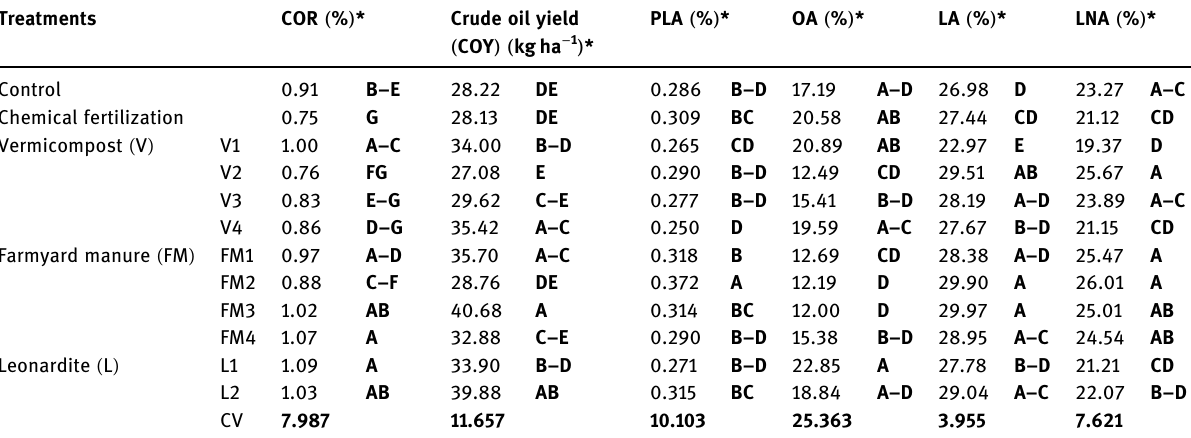
Table 3: E ff ects of di ff erent fertilizer forms on oil ratio, OY, and observed fatty acid composition of cowpea Treatments